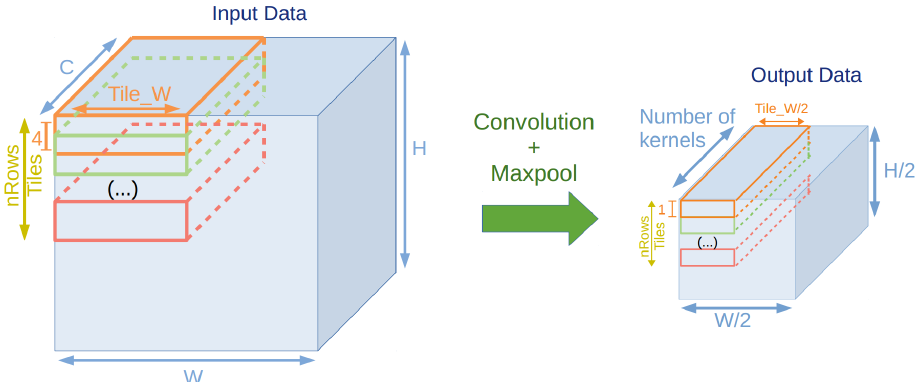
Figure 5. Data tiling